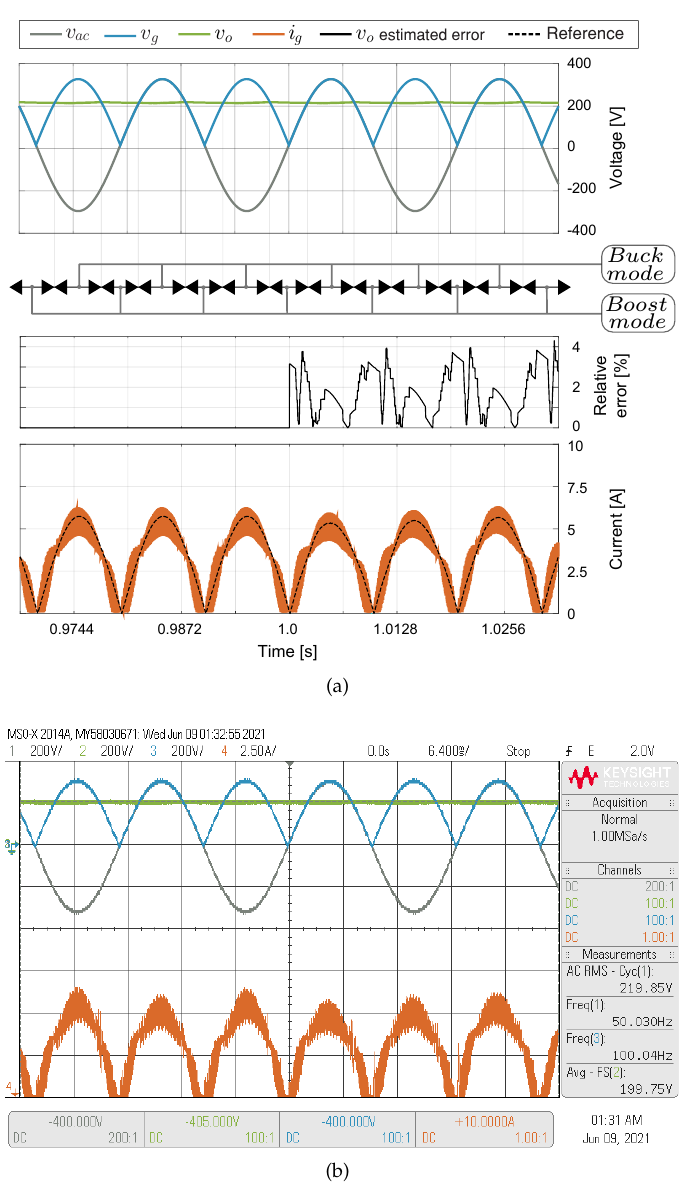
Figure 11. Simulated ( a ) and experimental ( b ) response of the double loop when the voltage sensor- less control is switched on at 1 s with v oref = 200 V. CH1: v ac (200 V/div), CH2: v o (200 V/div), CH3: v g (200 V/div), CH4: i g (2.5 A/div) and a time base of 6.4